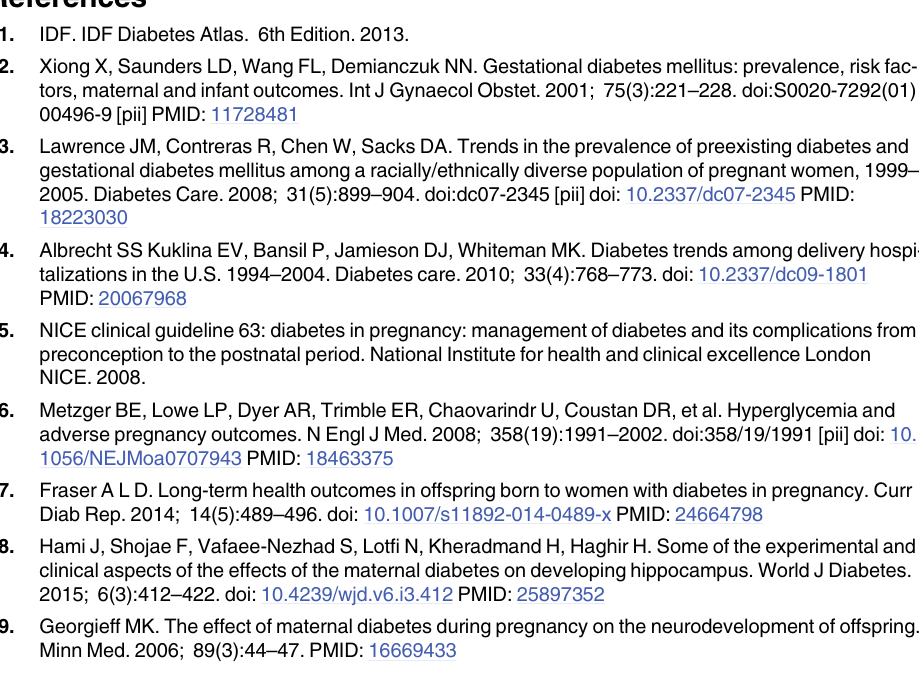
S3 Table. Rank correlation test and regression test for funnel plot asymmetry. S4 Table. Cumulative analysis for the MDI measures. These studies included had in common the age of the infants and so, by including the covariate age in the model, the variability due to the factor was taken into account. S5 Table. Cumulative analysis of the combined data relative to motor function (PDI). S6 Table. Cumulative meta-analysis for the combined IQ measures. Cumulative meta-analy- sis over time shows significant effects when adding later studies. So a covariate with the year of the study was also considered for meta-regression. No significant association of the year ( p - value 0.329), neither a reduction of the variation was found after